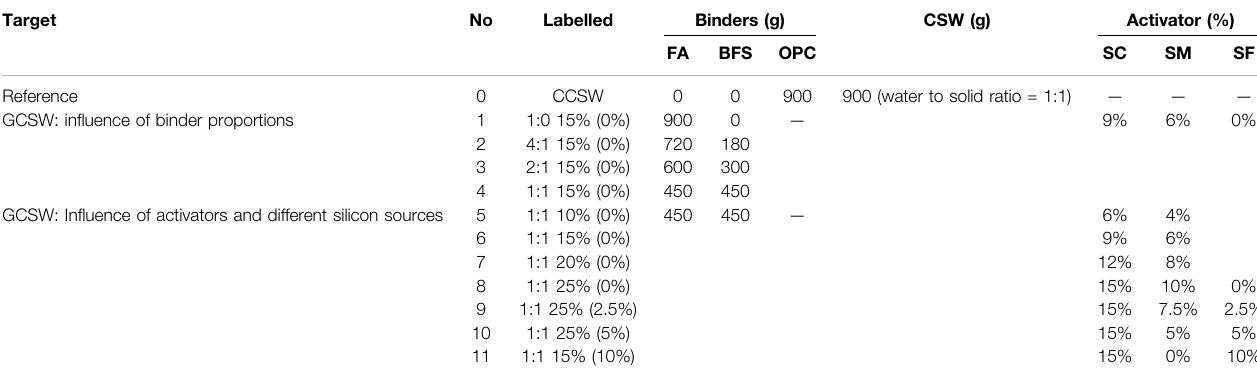
TABLE 2 | Mix proportions of the 12 groups.